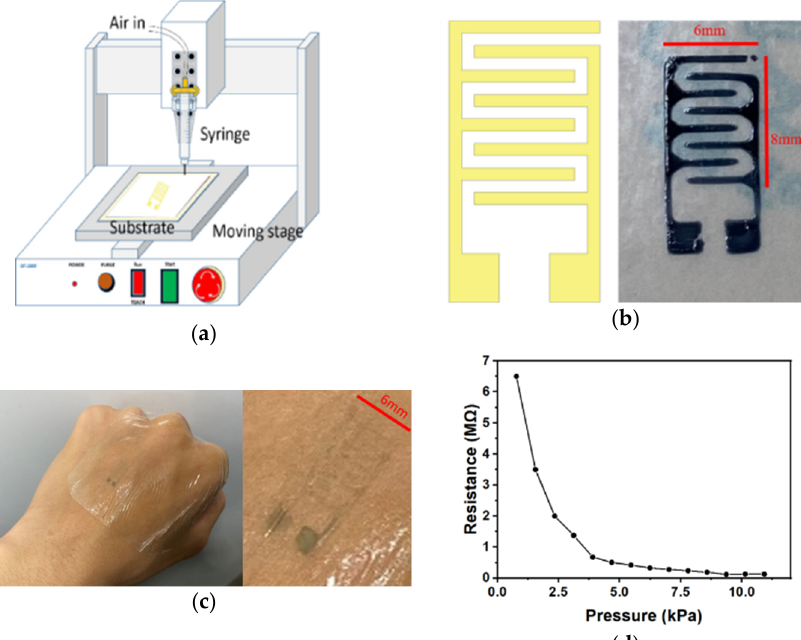
Figure 1. ( a ) Schematic of the setup used to print the detector, ( b ) results of the printed sensing device, printed with poly(3,4-ethylenedioxythiophene) polystyrene sulfonate ( PEDOT:PSS), ( c ) transparent silver nanowire (AgNW) detector attached to skin, and ( d ) characterization of the PEDOT:PSS